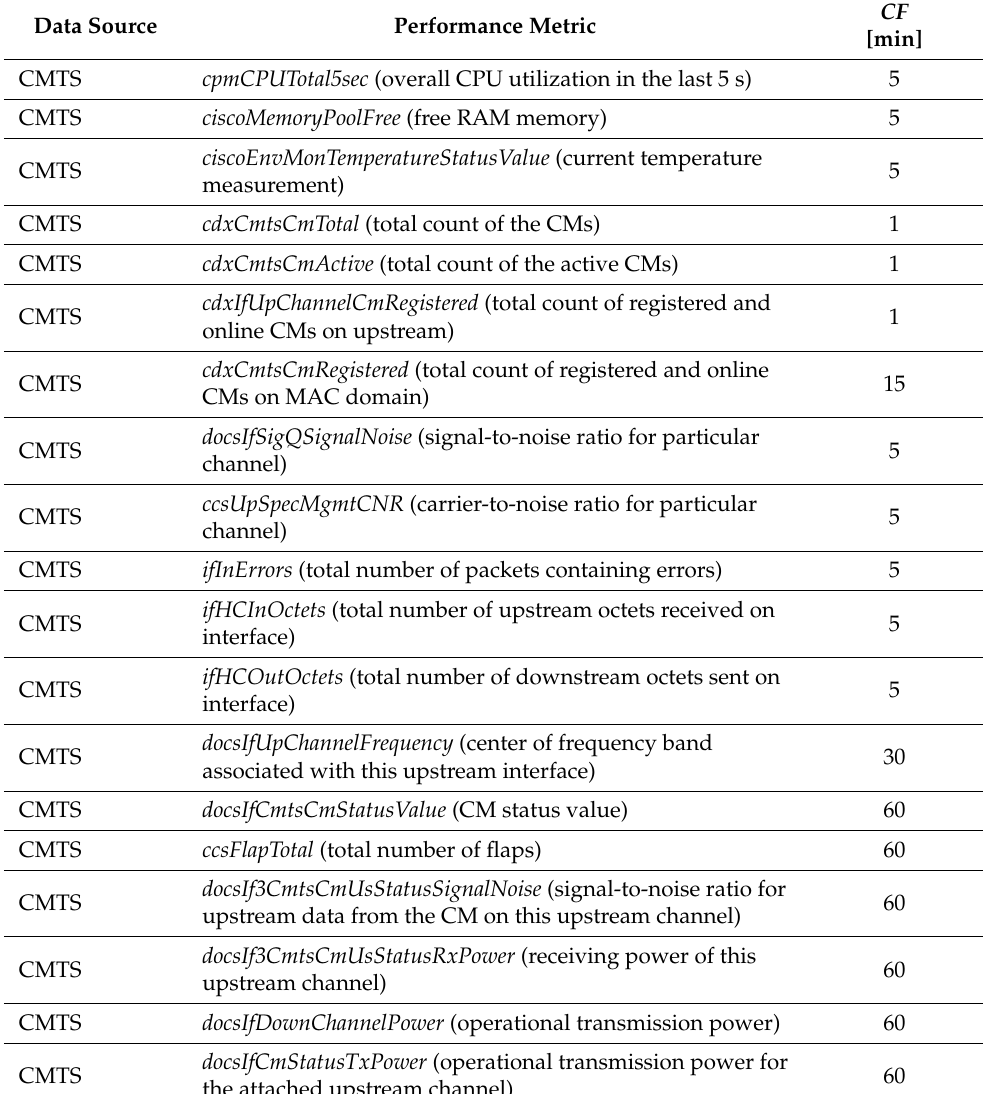
Table 1. Performance